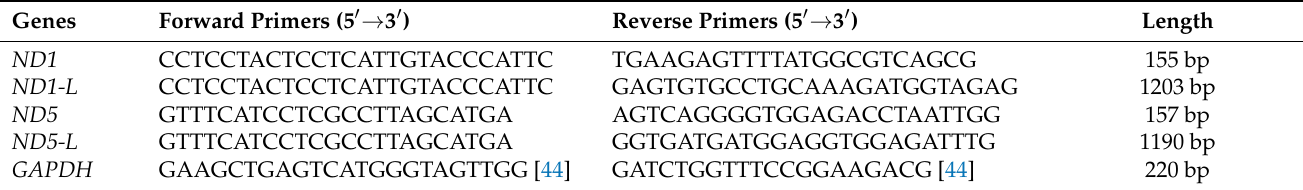
Table 2. Primer sequences and amplicon lengths for mitochondrial DNA copy number and DNA damage related genes.